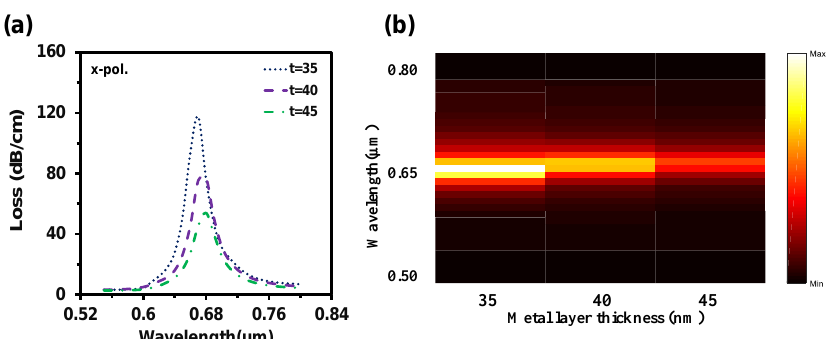
Figure 9. Impact of gold layer thickness variation ( t = 35 nm, 40 nm, and 45 nm) on ( a ) CL spectra and ( b ) light sensitivity alteration with the change of t when RI 1.35 is used in both channels. By considering the performance, we choose 40 nm as an optimal value. Figure 10a depicts the impacts of pitch value variations on CL. Here, the loss depth increased with the decrement of pitch value and the RW shifted from 0.68 µ m to 0.69 µ m and 0.7 µ m with these changes. On the contrary, loss depth reduced to 61 dB/cm and 53 dB/cm when the pitch value increased by 5% to 10% from neutral. Moreover, The RW fluctuated 0.68 µ m to 0.67 µ m and 0.66 µ m with this increment of the pitch value. Similarly, loss depth increased with the scaling down of the center air-hole diameter or vice-versa (from Figure 10b). Though the loss peak fluctuated, there was no significant change in RW. So, the WS re- mained the same. With the enlargement of the regular air-hole diameter, the effective index of core-guided mode decreased, resulting in the loss peak rising and redshift occurrence in RW. On the other hand, loss depth decreased with the scaling down of d and the RW faced the blue shift. All these are evident from Figure 10c. Small air-hole diameter has a strong influence in phase matching.